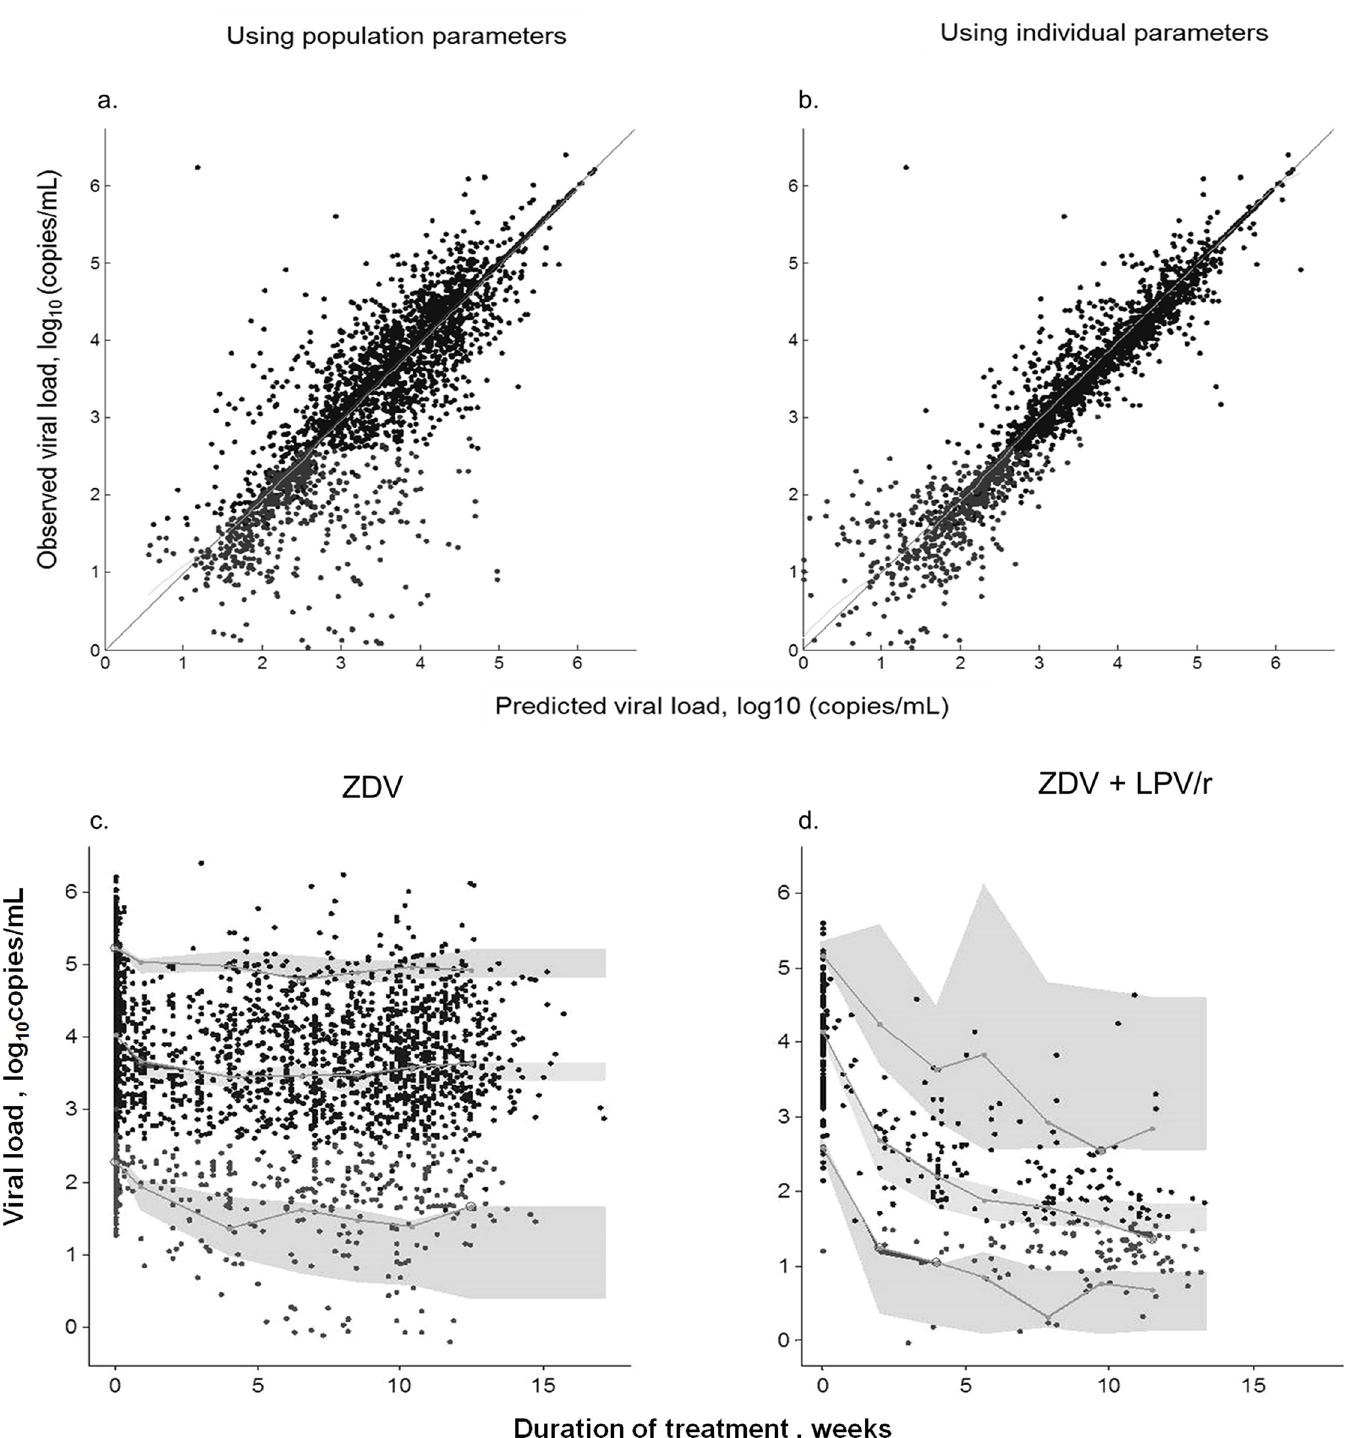
Fig 2. Diagnostic plots for viral load time-course model. Top: 2a and 2b: Observed versus model predicted viral load values (expressed as log 10 copies) of the population and individual predictions respectively. Solid black circles, measure values; grey symbols, simulation of below the limit of quantification data. Line, identity line. Bottom: Visual predictive check plots. (2c) Women receiving only zidovudine (ZDV); (2d) women receiving zidovudine plus lopinavir/ ritonavir (ZDV+LPV/r).The lines denote the median, 5 th and 95 th percentiles for the observed data. The grey areas stand for the 95% confidence intervals of the median, 5 th and 95 th model prediction